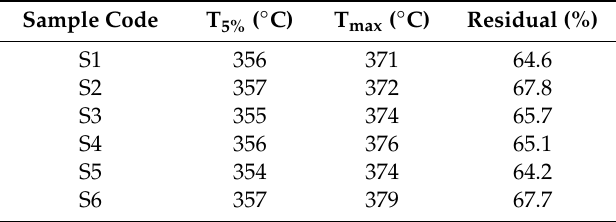
Table 2. The thermo-oxidative stability of polysiloxane foam with di ff erent MAPOSS